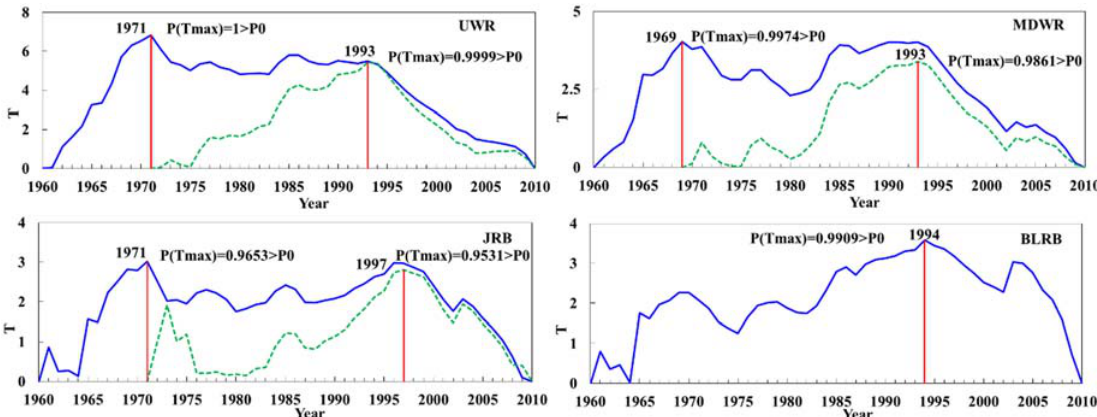
Figure 5. Segmentations and change points of mean annual streamflow in the four zones. The blue solid line and the green dotted line refer to the first and second iteration and segmentation process, respectively.